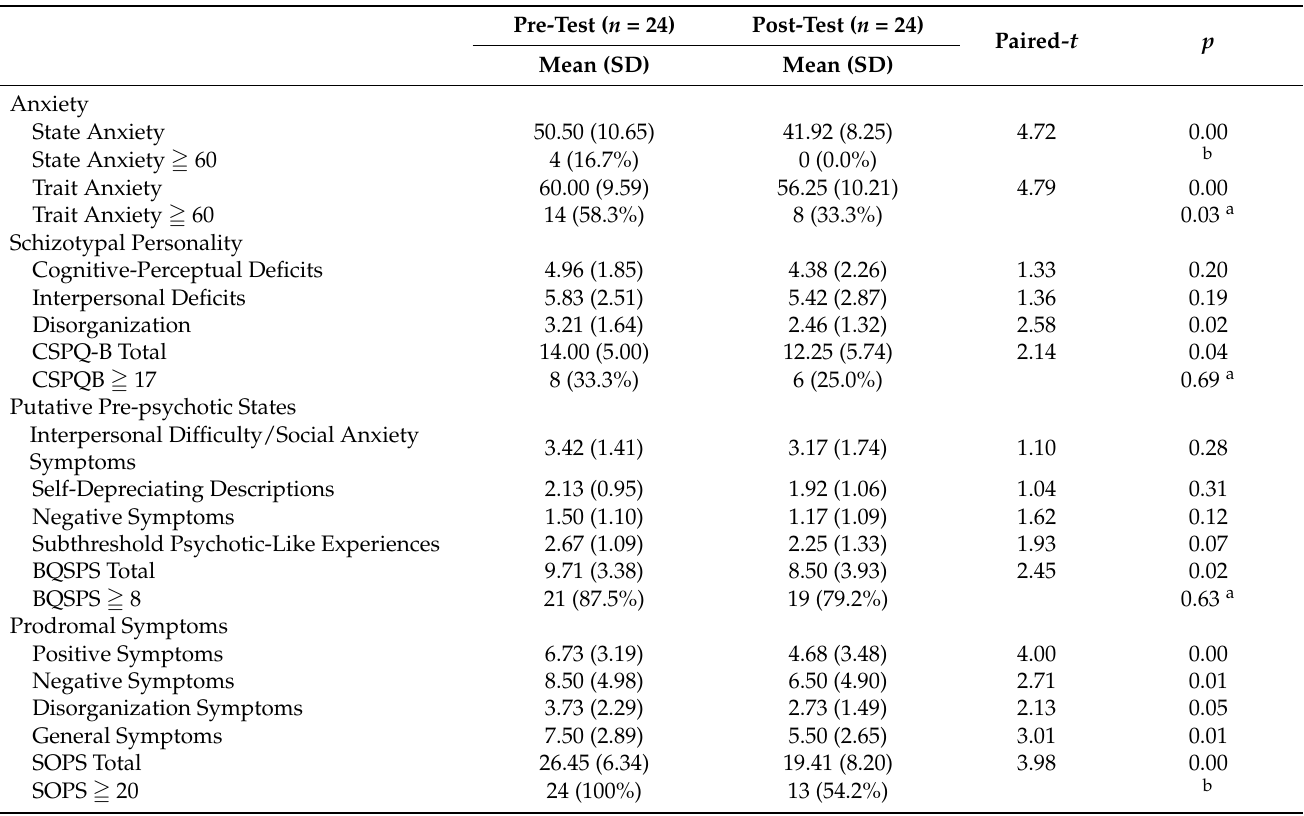
Table 3. The differences in anxiety and mental risks between pre- and post-test.